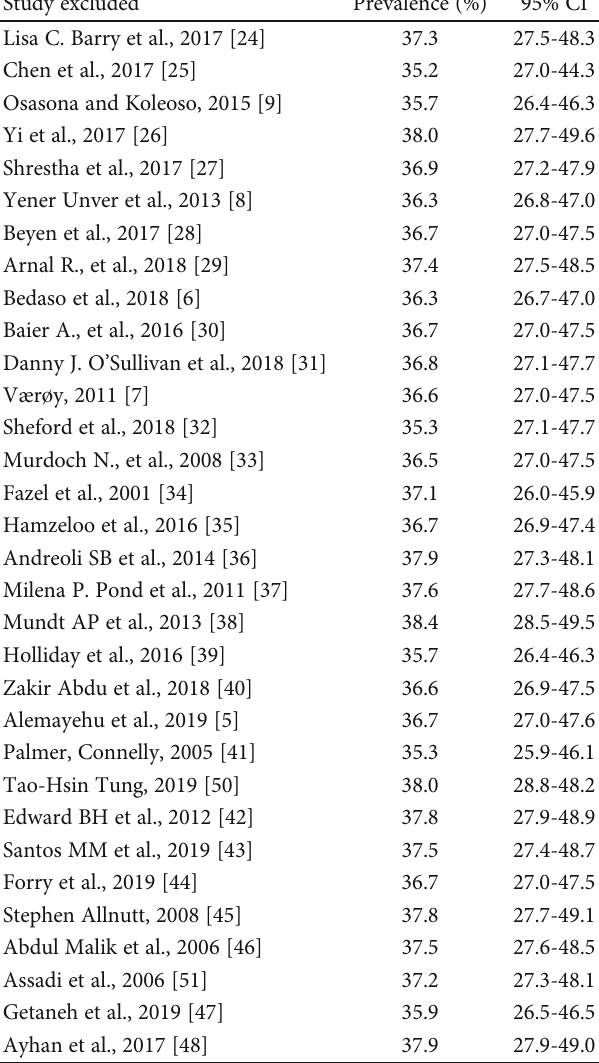
Table 3: One-leave-out sensitivity analysis of the prevalence of depression among prisoners for each study being removed at a time (prevalence and 95% con fi